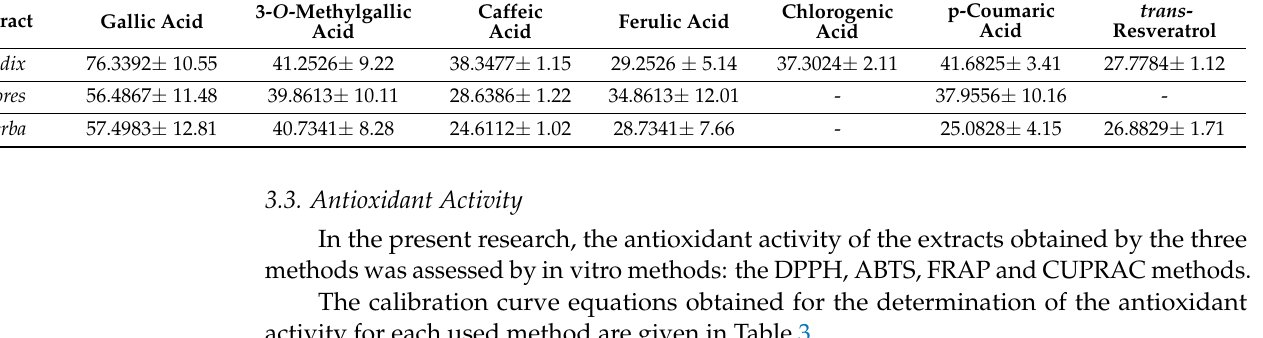
Figure 5. HPLC-DAD chromatograms using the developed method of mixed standards at 324 nm. Red line corresponds to the ethanolic solution of Lysimachia nummularia herba samples with the standard solution, green line corresponds to the ethanolic extracts without the standard solution.